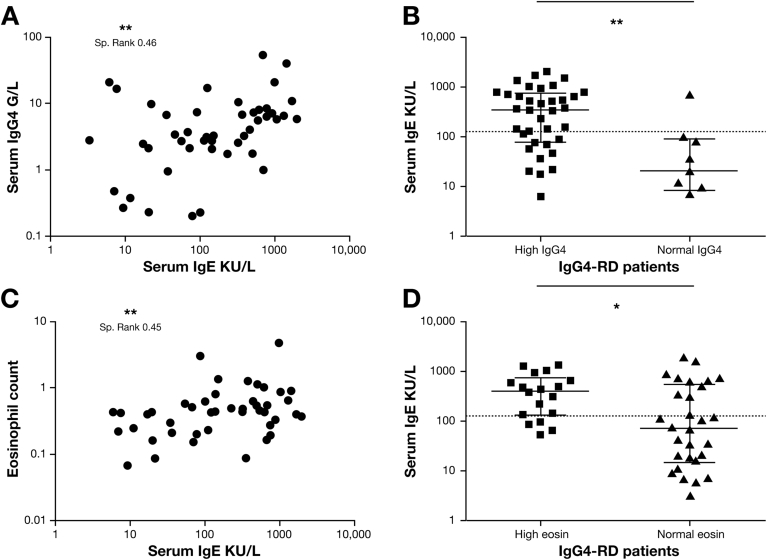
The relationship of serum IgE with serum IgG4 and peripheral blood eosinophil counts in IgG4-RD. (A) Correlation plots showing serum IgE (kIU/L) plotted against serum IgG4 (g/L) in IgG4-RD. (B) Dot plots of serum IgE in IgG4-RD patients with a high (≥1.4 g/L) or normal serum IgG4. Dashed line is the serum IgE upper limit of normal (≥125 kIU/L). (C) Correlation plots showing blood eosinophil count (cells/μL) plotted against serum IgE (kIU/L) in IgG4-RD. (D) Dot plots of serum IgE in IgG4-RD patients with a high (≥500 cells/μL) or normal eosinophil count. Dashed line is the serum IgE upper limit of normal (≥125 kIU/L). Spearman rank correlation and P values are expressed as NS ≥0.05, *P < .05, **P < .01. Mann-Whitney P values, where NS P ≥ .05, *P < .05.